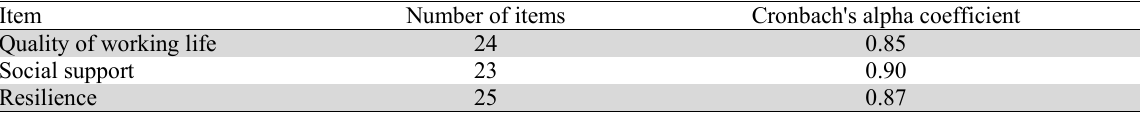
The number of items and Cronbach's alpha coefficient value for the measuring instruments Item